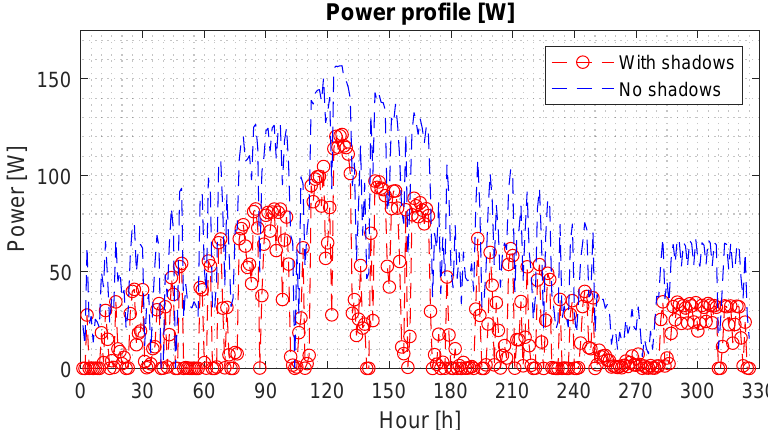
Figure 14. Power profile hours with shadow.